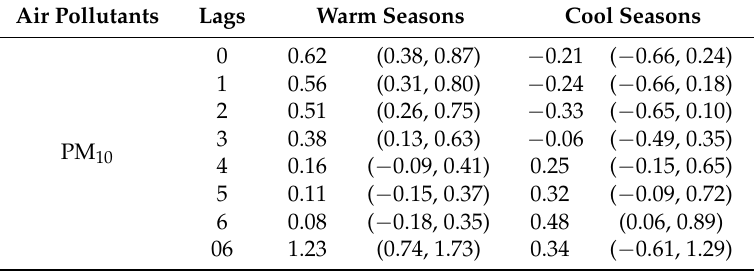
Table 4. Percent change (mean and 95% CI) in daily outpatient visits for eczema associated with 10 μ g/m 3 change in air pollutant concentrations, stratified by seasons.